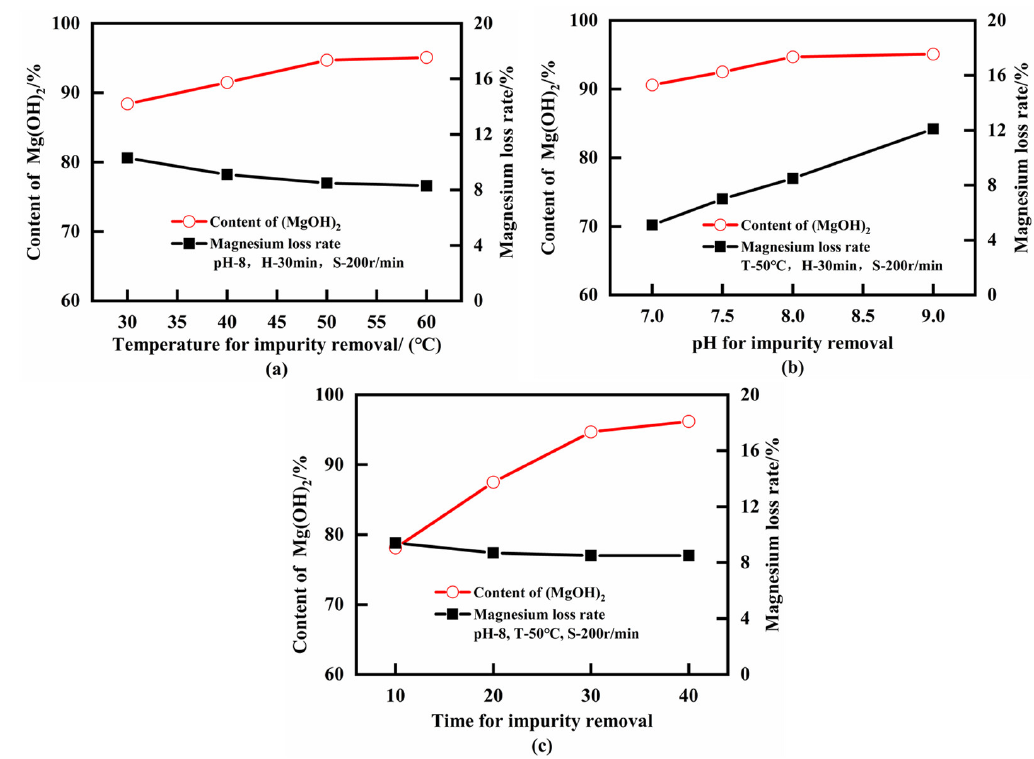
Figure 8. Impurity removal results of acid leachate ( a ) temperature for impurity removal; ( b ) pH for impurity removal; ( c ) time for impurity removal.